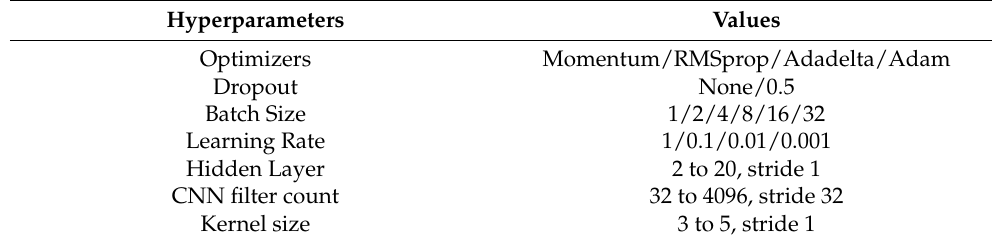
Table 1. Used hyperparameters in